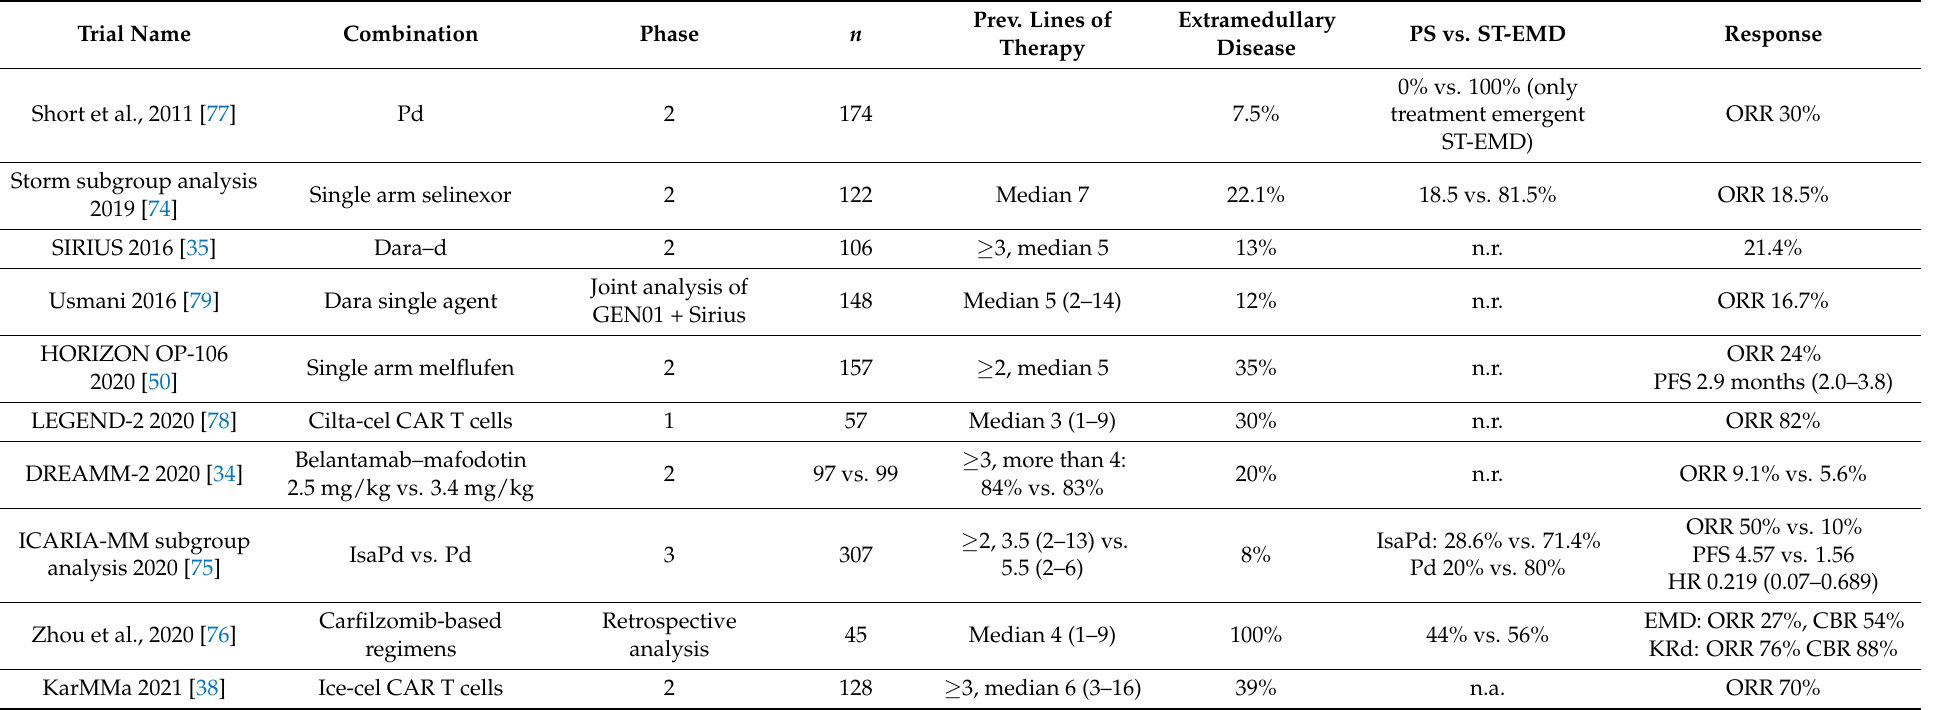
Table 4. Trials reporting outcome of patients with extramedullary